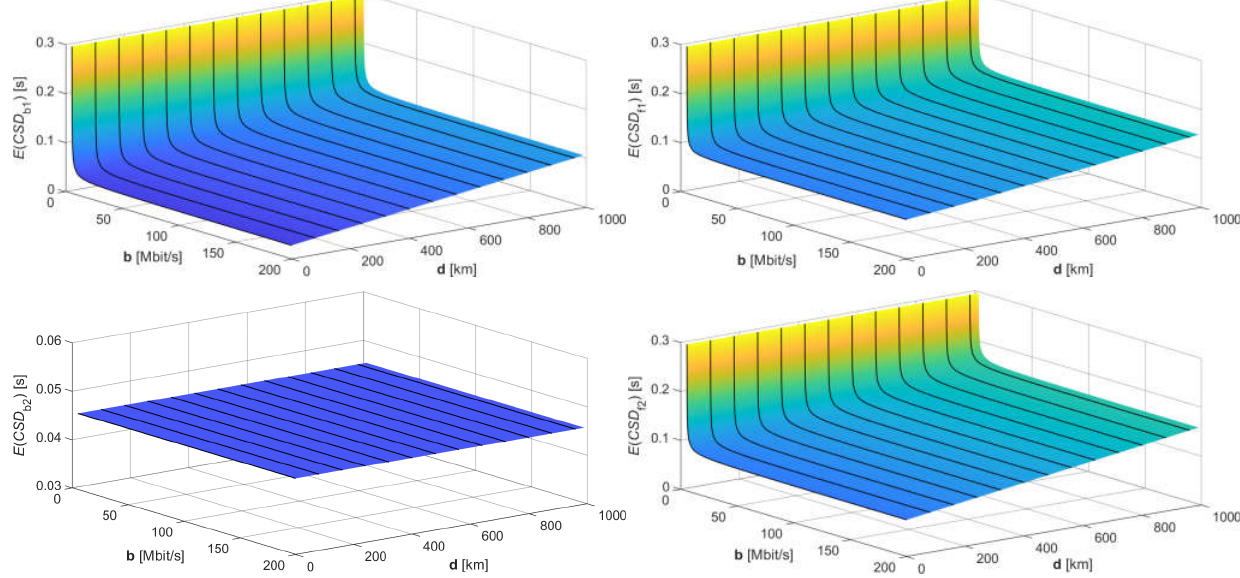
Figure 11. Selected results for data set 8 from Table 1.